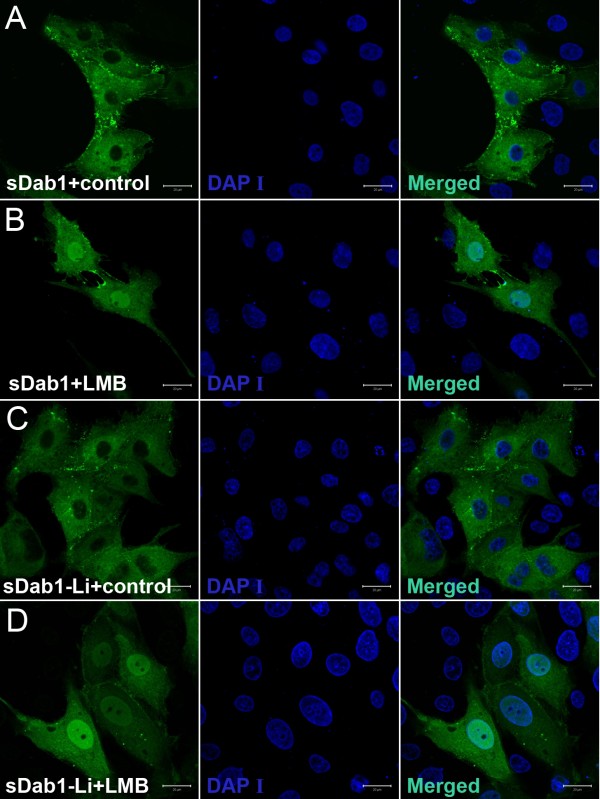
Nucleocytoplasmic shuttling of sDab1 isoforms in IBRS2 cells. sDab1-GFP or sDab1-Li-GFP was transiently expressed in IBRS2 cells, and 24 hours after transfection, the cells were treated with methanol (vehicle control) (A or C) or 20 ng/ml LMB (B or D), and after 12 hours of treatment, the cells were fixed and counterstained with DAPI to visualize the nucleus. Scale bars: 20 μm.